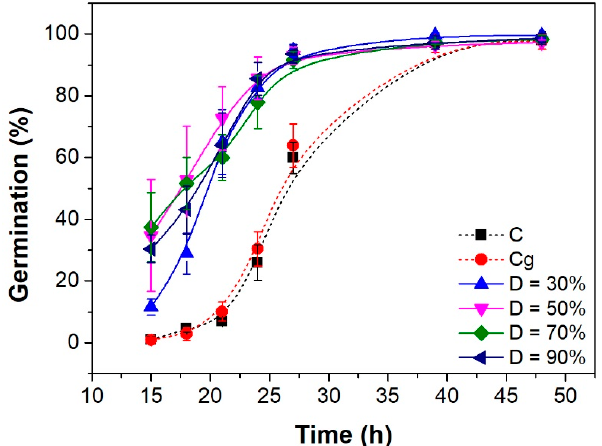
Figure 10. Germination acceleration of argon-treated wheat seeds with different voltage duty cycles for 4 min. Germination curves were fitted with the Hill function.